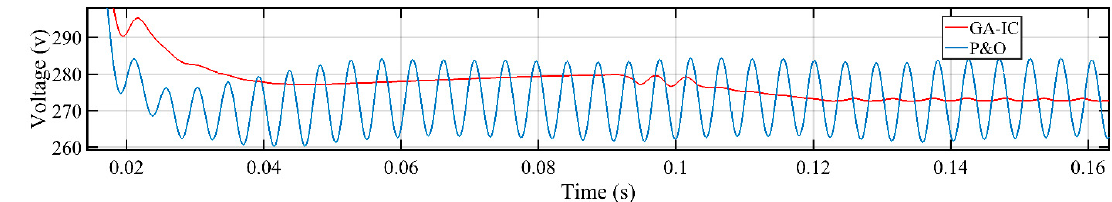
Figure 26. Case 2 voltage comparison of modified GA-IC vs. P&O.